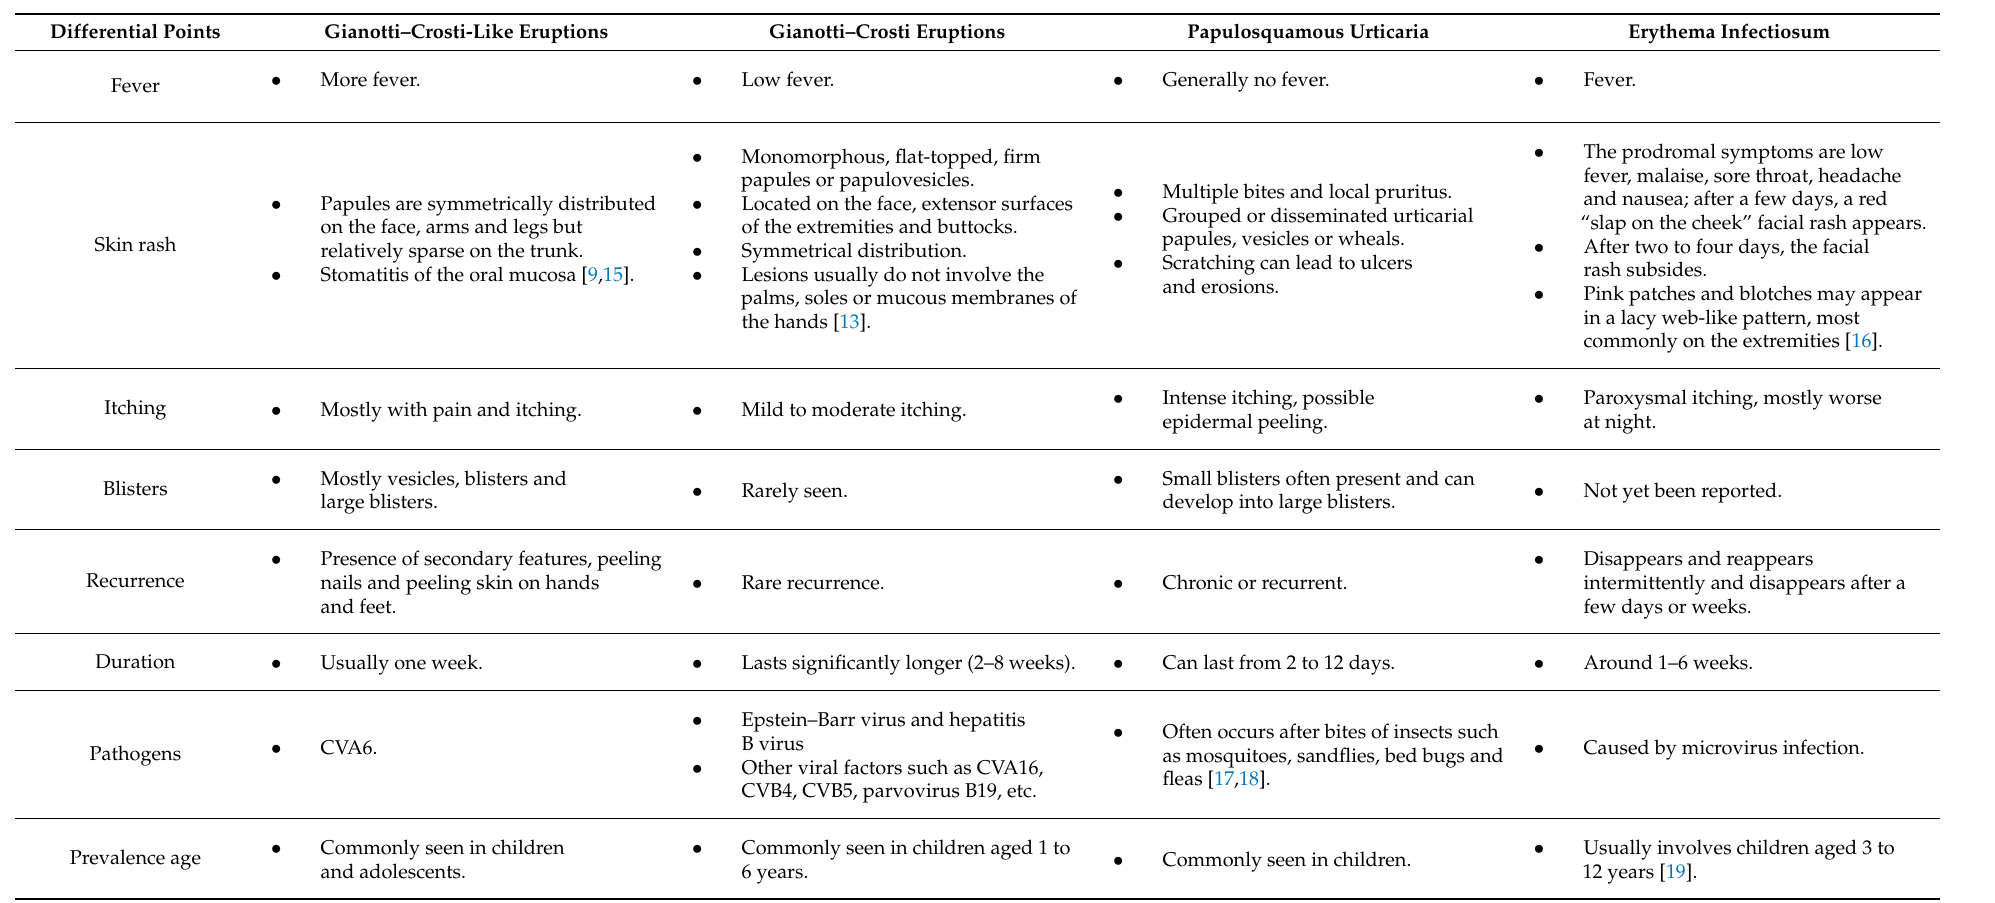
Table 1. Differential diagnosis of Gianotti–Crosti-like